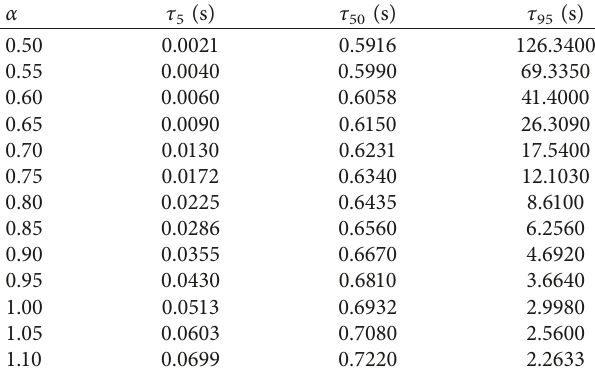
5 , τ 50 , and τ 95 for